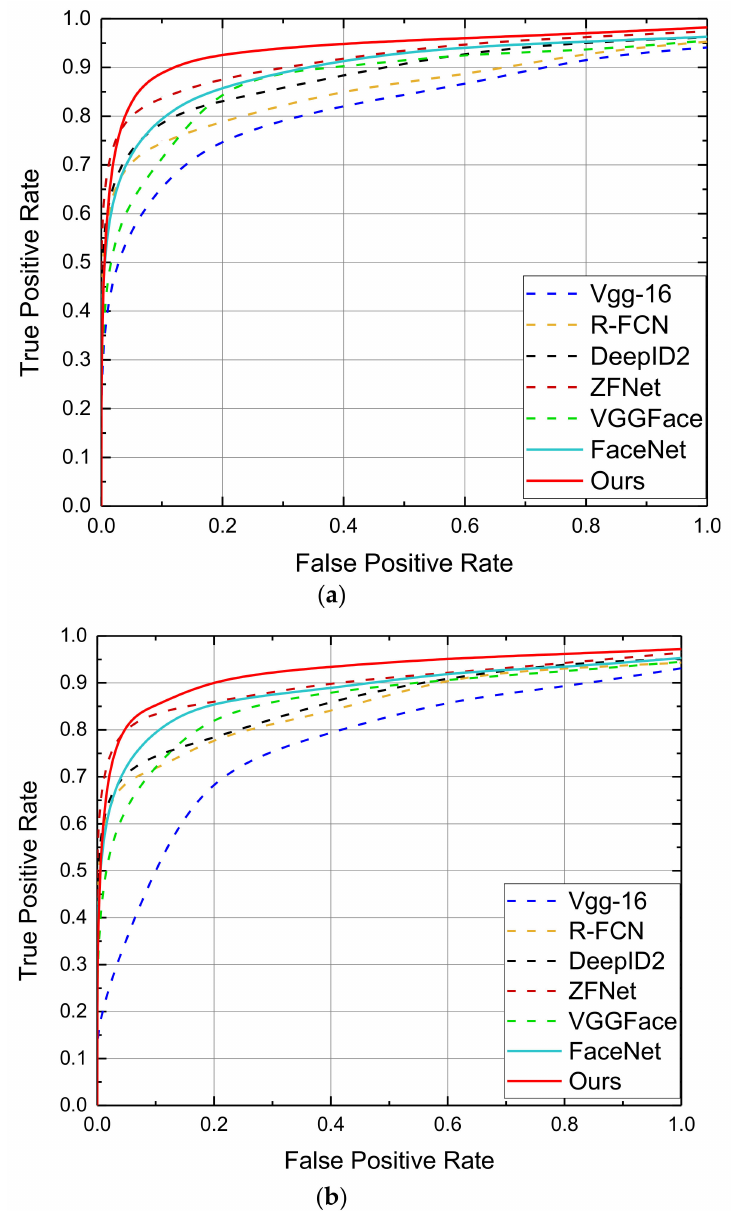
Figure 18. ROC curve for different models on validation sets and test sets. ( a ) ROC curve for different models on testing sets; ( b ) ROC curve for different models on validation